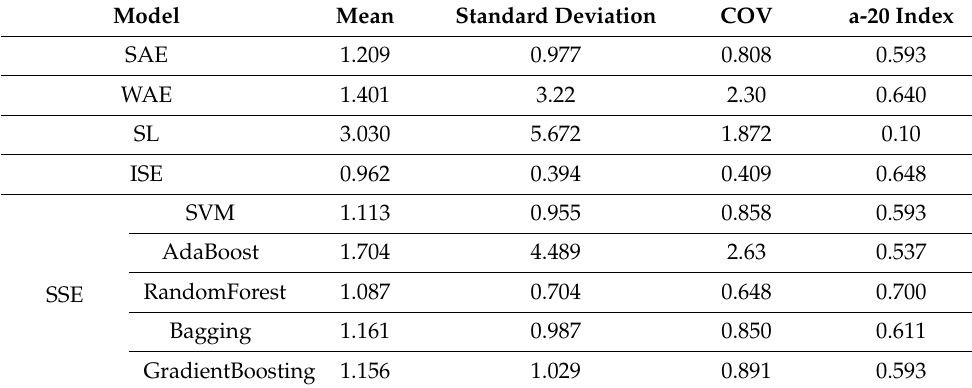
Table 6. Properties of the measured-to-predicted values for test set.